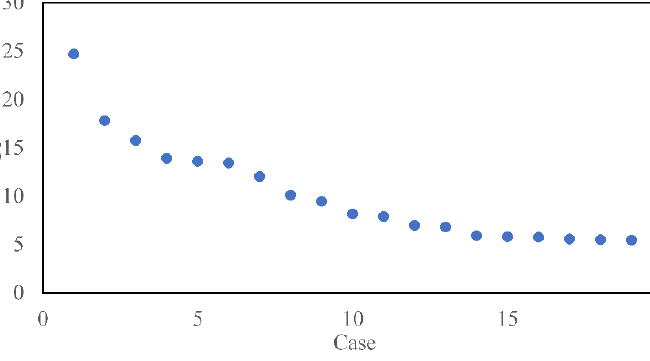
Figure 2. 20 cases of Froude parameters.